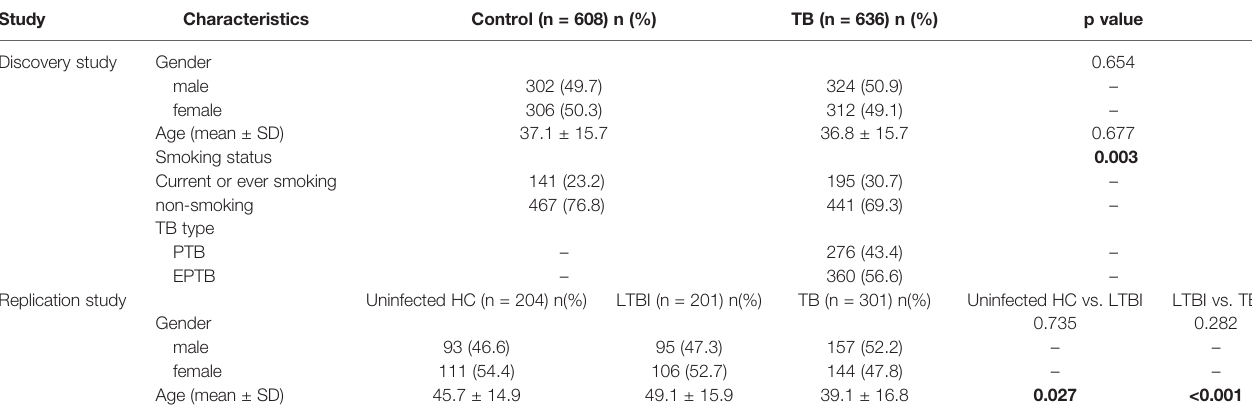
TABLE 1 | Characteristics of the discovery and replication studies.